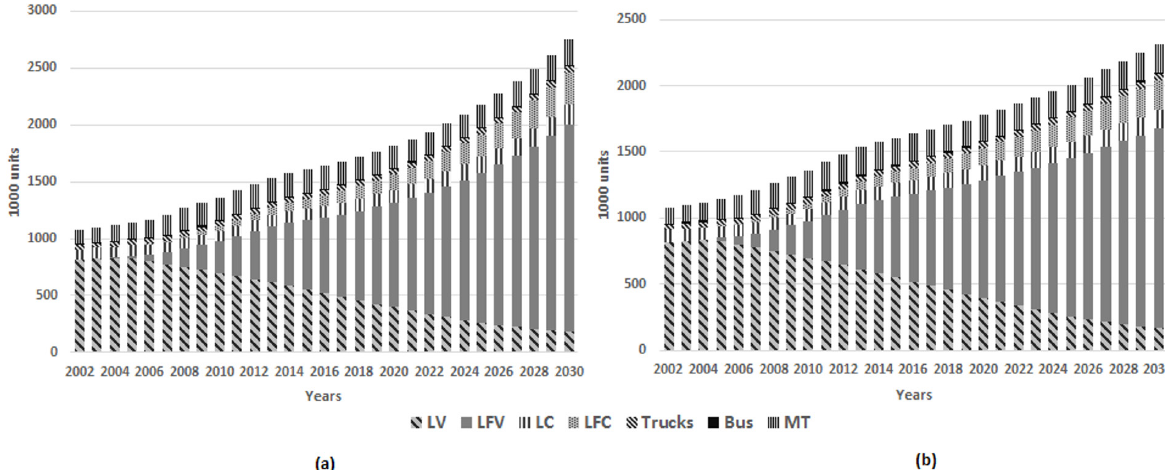
Figure 2 - Scenarios of vehicular fleet evolution in the MRPA (period between 2002 and 2030). ( a ) Pessimistic scenario of the fleet (bigger quantity of license in the period). ( b ) Optimistic scenario of the fleet (smaller quantity of licenses in the period).